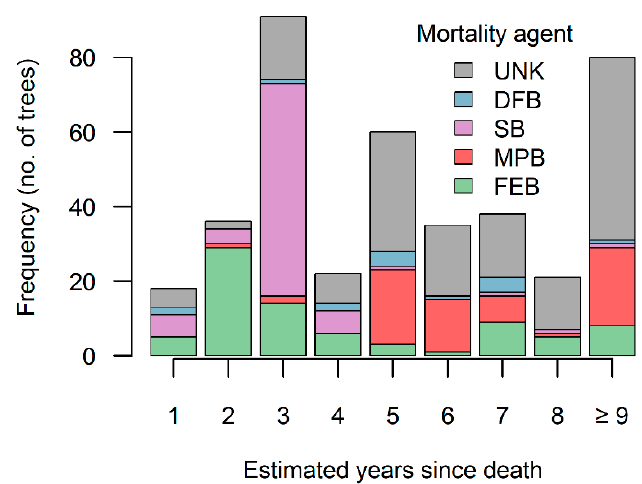
Figure 2. Estimated years since death and mortality agent for dead trees measured in field plots. UNK: Unknown or other; DFB: Douglas-fir beetle; SB: Spruce beetle; MPB: Mountain pine beetle; FEB: Fir engraver beetle.